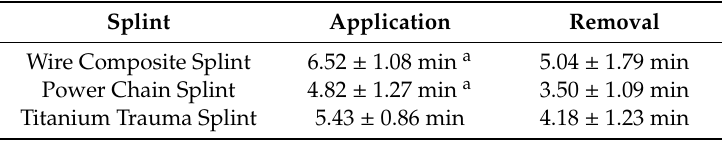
Table 1. Working time for splint application and removal.